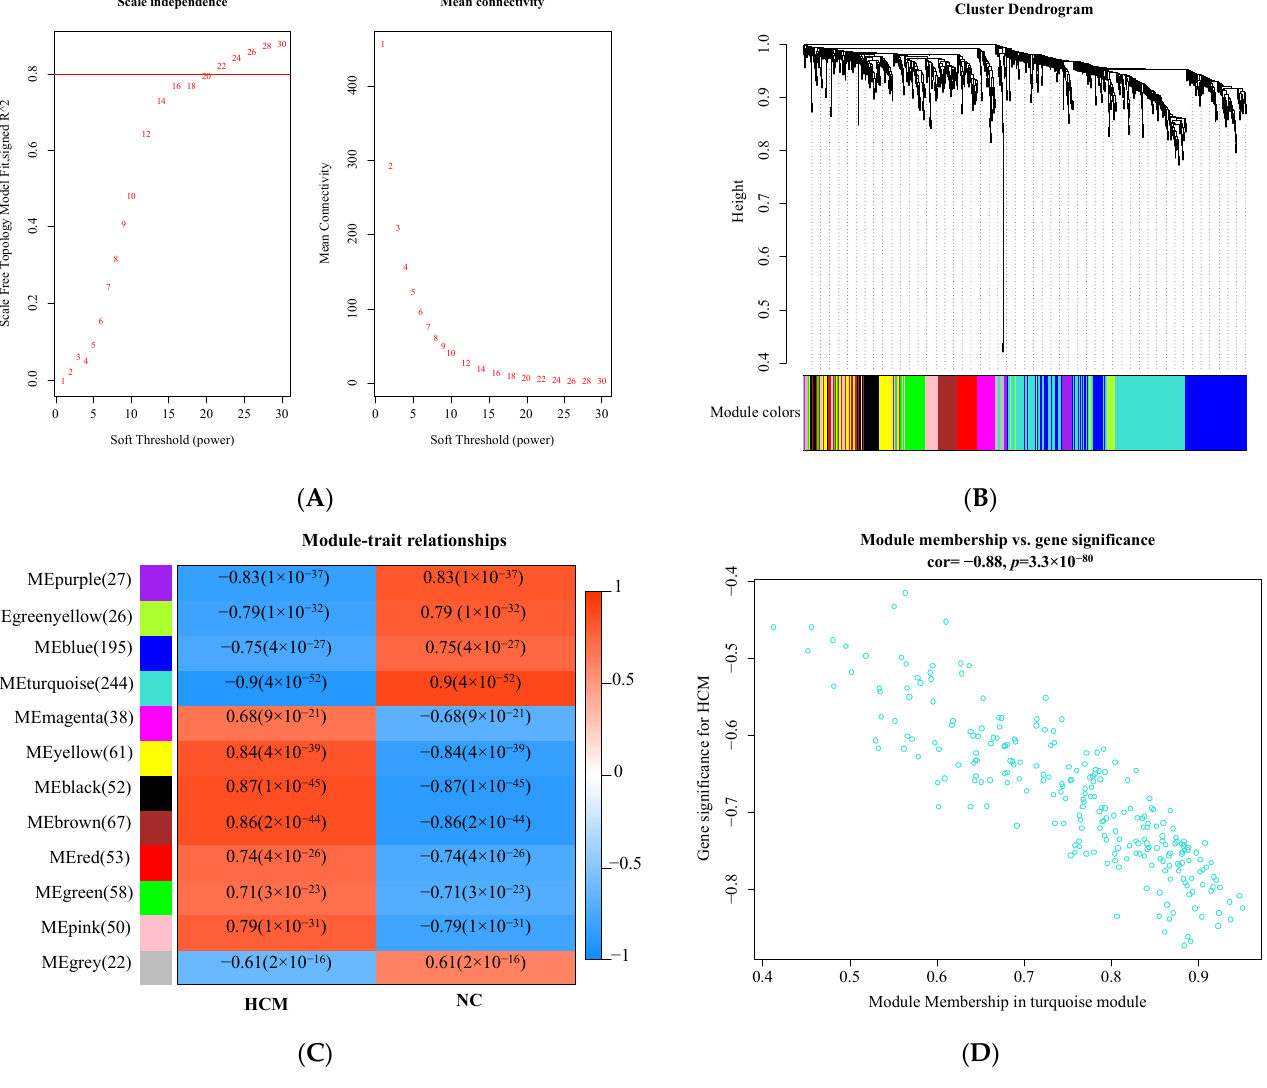
Figure 3. Results of WGCNA. ( A ) Soft threshold analysis. Each power corresponds to scale inde- pendence and mean connectivity. A soft threshold of 20 (red horizontal line) was chosen for the construction of the scale-free topology module. ( B ) Cluster dendrogram. Each branch represents one gene, and each color at the bottom represents one coexpression module. ( C ) Module-trait rela- tionships between MEs and clinical phenotype. The upper number in the color grid represents the correlation as well as its p -value. Red indicates a positive correlation, and blue indicates a negative correlation. ( D ) The scatterplot of module membership and gene significance in turquoise module.